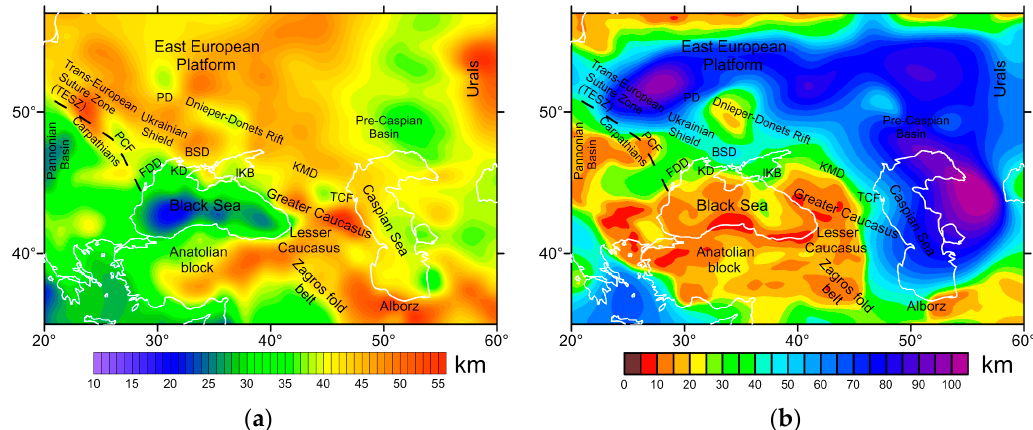
Figure 4. ( a ) Depth to the Moho from the sea level; ( b ) effective elastic thickness (EET) of the lithosphere [48].